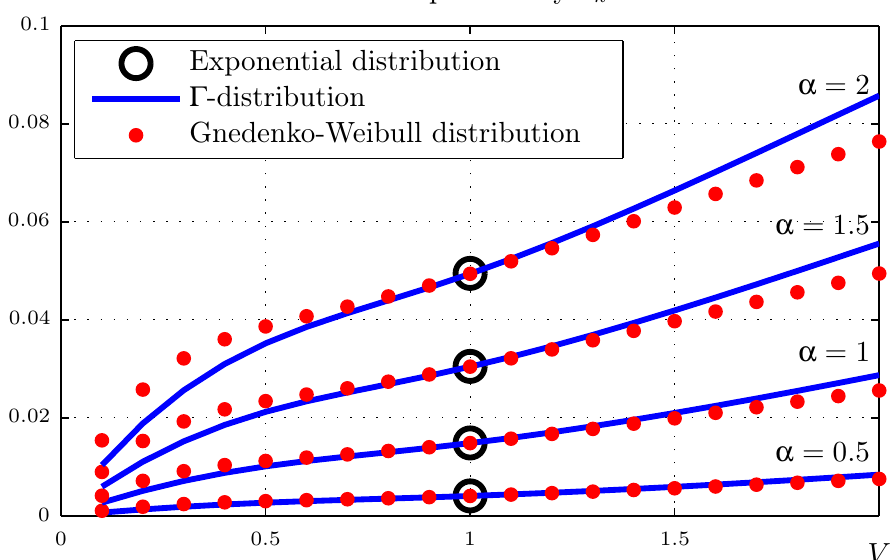
Figure 5. Probabilities of the compressor shop failure (“2-out-of-4”) for b = 10 days, g = 40 days.